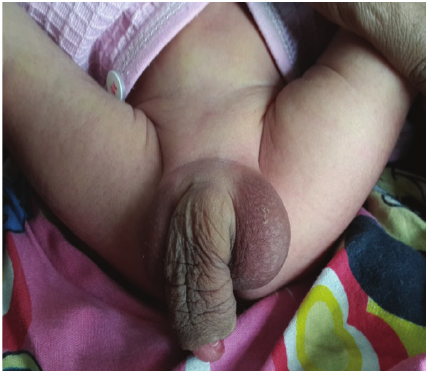
Figure 1: Deformed phallus.